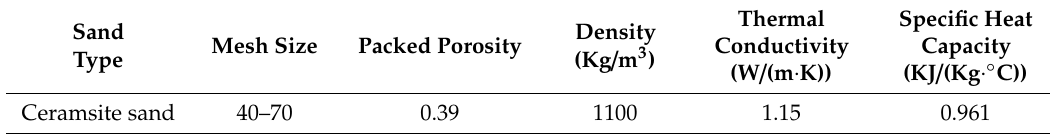
Table 1. Physical properties of